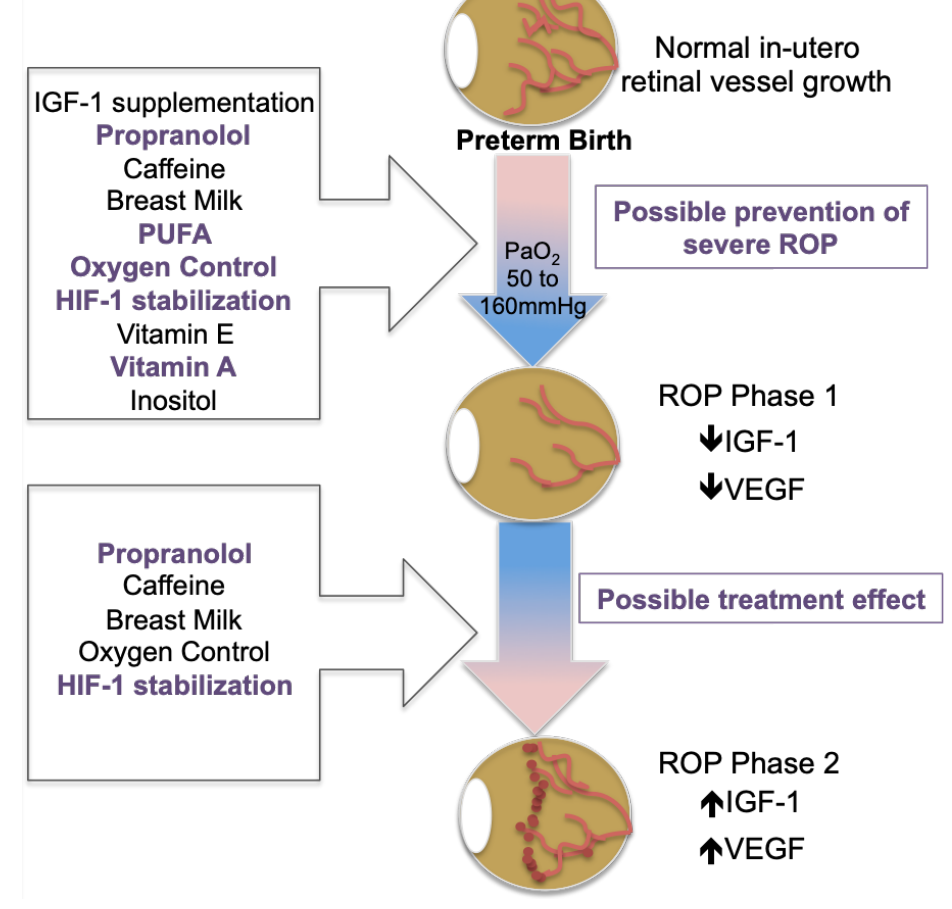
Figure 2. Preventive strategies target post-natal molecular